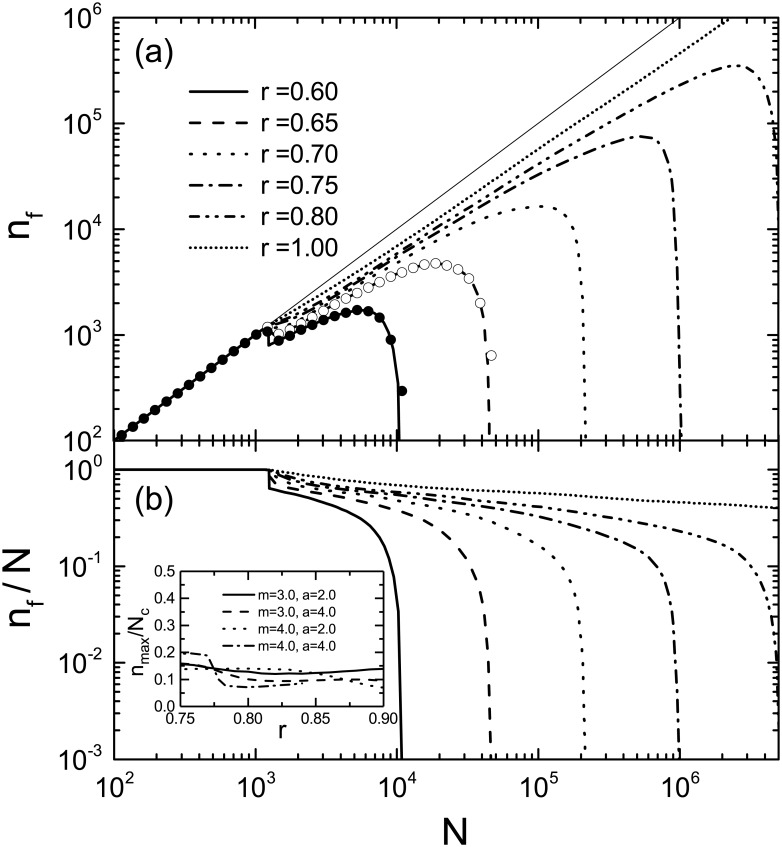
Relation between the largest component size nf and the initial network size N.(a) Largest component size nf after completing cascading overload failures as a function of the size N of initial ERRGs, for various values of r. The thick lines indicate nf calculated by Eq (9) and filled and open circles on thick lines show the results obtained by the numerical simulation described in the main text. The thin straight line is a guide to the eyes for nf = N. (b) Relative largest component size nf/N as a function of N. Lines have the same meanings as those in (a). All the results are calculated for 〈k〉0 = 5.0, m = 4.0, and a = 2.0. The inset shows the r dependence of nmax/Nc. Lines in the inset represent results for ERRGs with different values m and a.